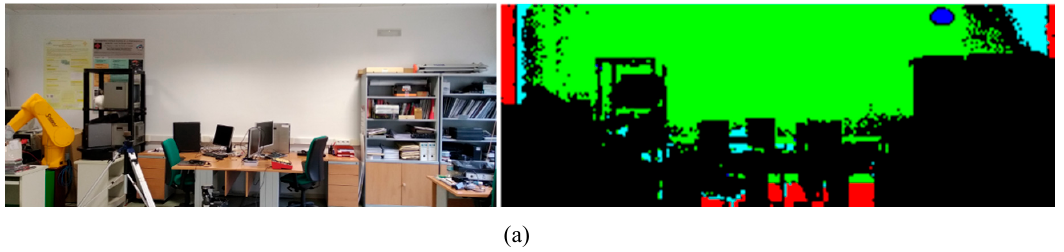
Figure 17. 3D-TTA Module 3.2: Segmentation into regions through a temporal analysis of thermal maps. ( a ) The test wall and the visualization of the segmented regions in different colors. ( b ) Corresponding prototype vectors are in the same colors.